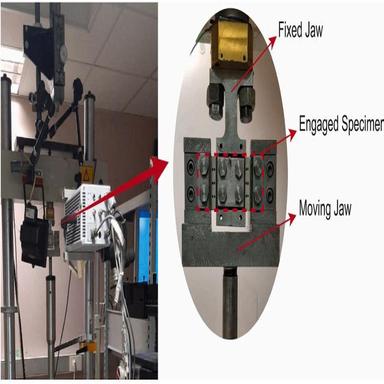
Testing set-up for high strain shear behavior of A-SMC composite.